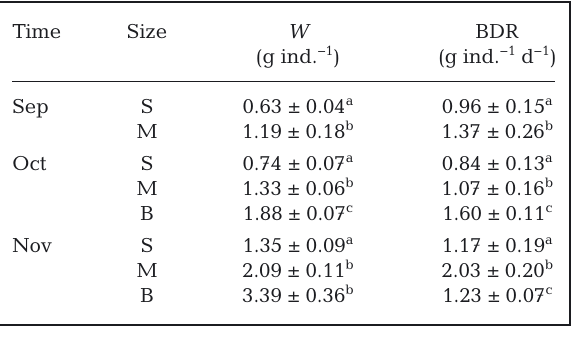
Table 4. Tissue dry weight ( W) and biodeposition rate (BDR) of bay scallop Argopecten irradians in different months. S: small size scallops; M: medium size; B: big size. Different letters in the same month and column indicate significant differences (p < 0.05)